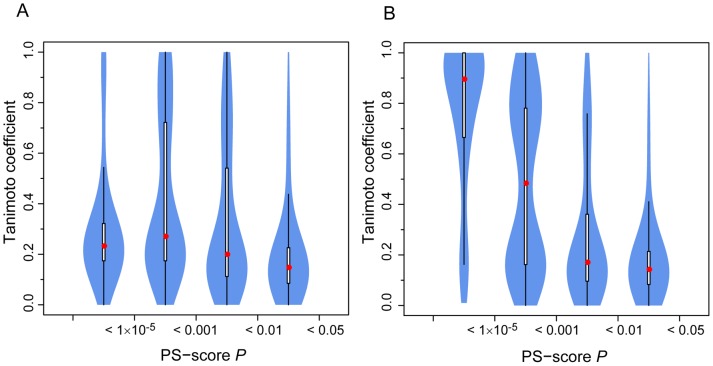
Violin plot of chemical similarity of ligands found in structurally similar pockets.(A) All 7 million pairs of pockets at PS-score P-values<0.05 are considered. The x-axis labels mark similarity regimes for pocket pairs considered. (B) The subset of pocket pairs from proteins with low pairwise global structural similarity at the TM-score <0.4. A Violin plot is derived from a boxplot by scaling the width of the box such that the area is proportional to the number of pairs of ligands observed. The white bars range from 25th to 75th percentile, and the whiskers extend to a distance of up to 1.5 times the interquartile range. The red spheres represent the medians.